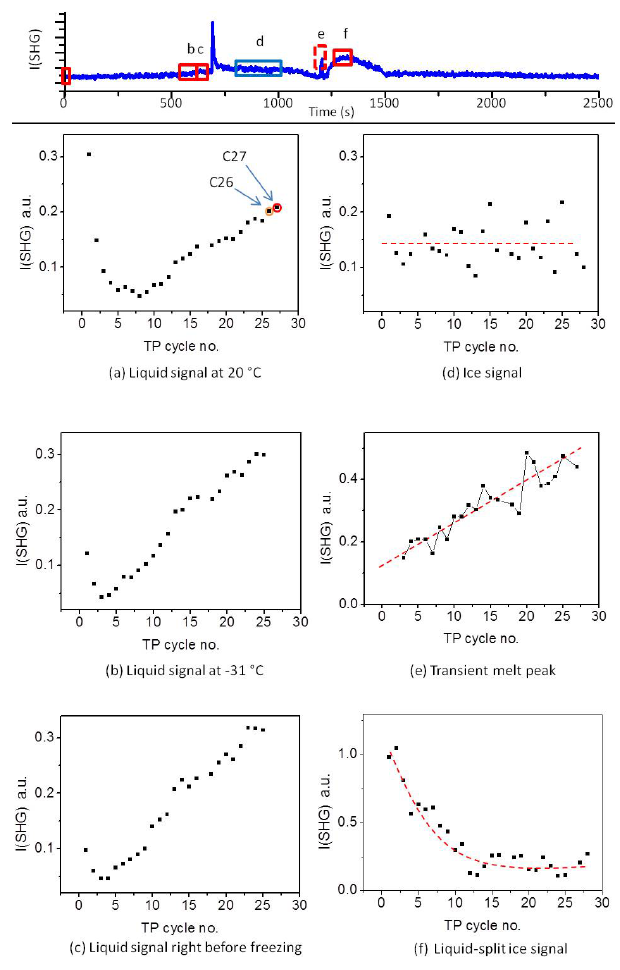
Figure 4. Upper panel: A sample plot of SHG vs. time during the standard TP. (a–f) The averaged SHG signal as a function of TP cycle number at the different time slots marked with red and blue rectangles in the upper panel. The red rectangle corresponds to liq- uid phase, while the blue rectangle corresponds to ice phase. The dashed red lines on the plots are guiding lines through the data points.